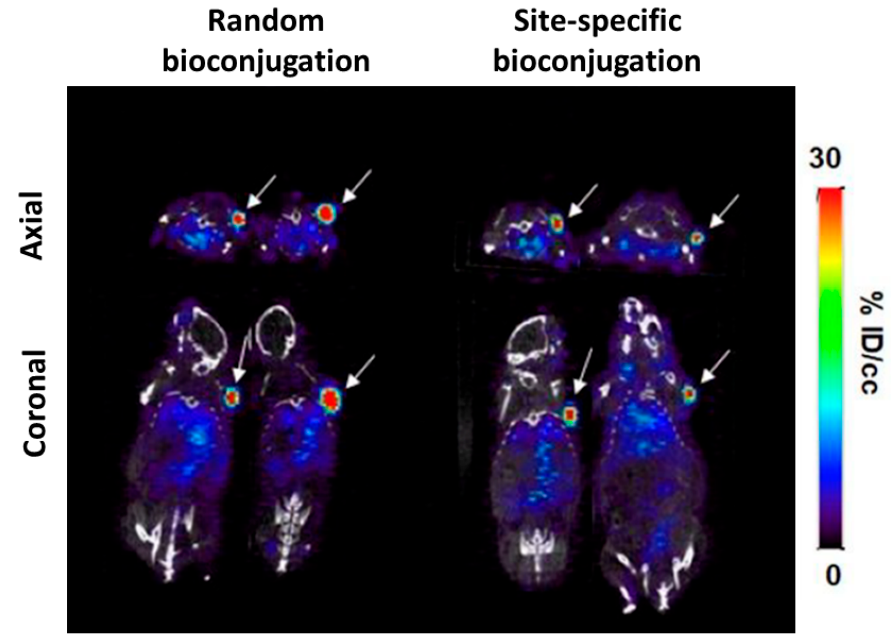
Figure 2. Single slice PET/CT images of random (left) and site-specific unnatural amino acid pAMF-DBCO SPAAC (right) conjugated [ 89 Zr]Zr-DFO-Trastuzumab 96h post injection. Adapted with permission from Ahn et al. [53]. Copyright 2020, American Chemical Society.